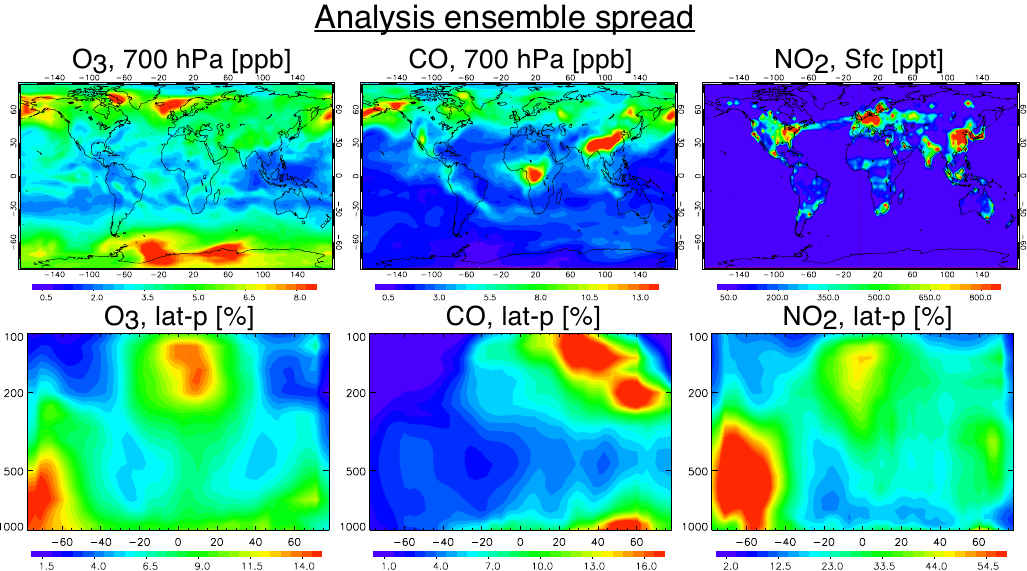
Fig. 16. Analysis ensemble spread of O 3 (left), CO (centre), and NO 2 (right) averaged over 16–30 July 2007. Upper panels show the global distribution at 700hPa. Lower panels show the latitude-pressure distribution of the percentage ratio of the zonal mean analysis ensemble spread to the zonal mean analysis ensemble mean concentration. The red (blue) colour indicates relatively high (low) values.